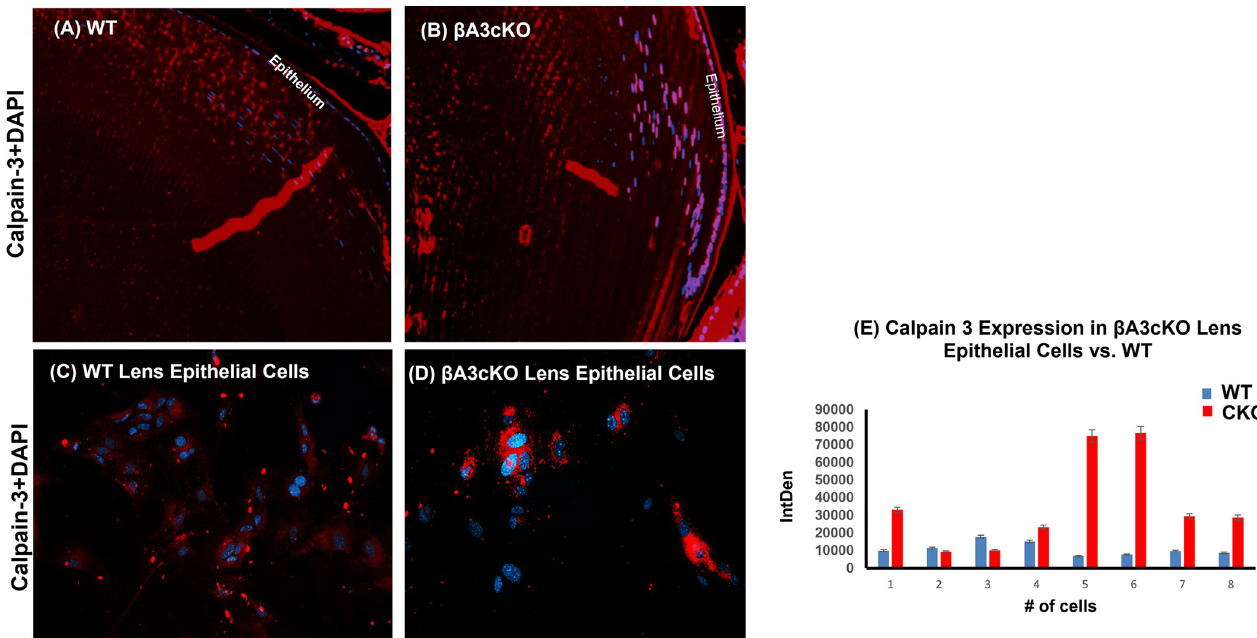
Fig 6. Immuno-localization of calpain -3 in Lenses and cultured lens epithelial cells of β A3cKO and wild-type mouse. (A) and (B) Immunohistochemical localization of calpain-3 in in lenses of β A3cKO and wild type lenses. (C) and (D) Immunocytochemical localization of calpain-3 expression in cultured lens epithelial cells from wild-type lenses (C) and those from β A3cKO lenses (D). (E) Calpain-3 expression was quantified in lens epithelial cells from wild type lenses (C) and β A3cKO lenses (D) using image J. Note and that the immunohistochemical localization showed that calpain-3 was mostly localized in the outer cortical region in the wild type lenses (A), but it was mostly associated with nuclei in the β A3 β A3cKO lenses (B). There was an increased calpain -3 expression in β A3cKO lens epithelial cells compared to control lens epithelial cells (Fig 6E).